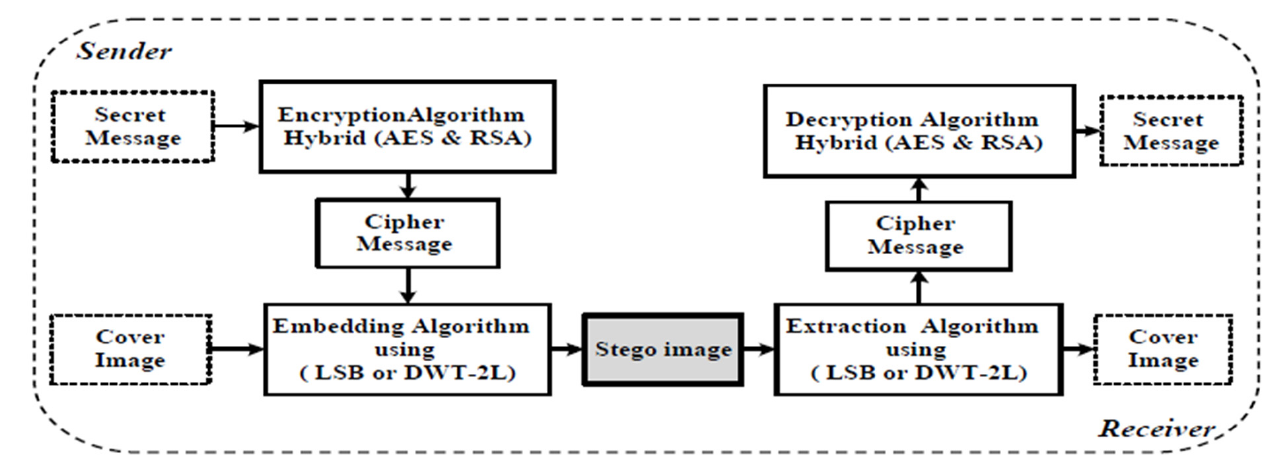
Figure 4. Proposed framework using hybrid encryption algorithm.